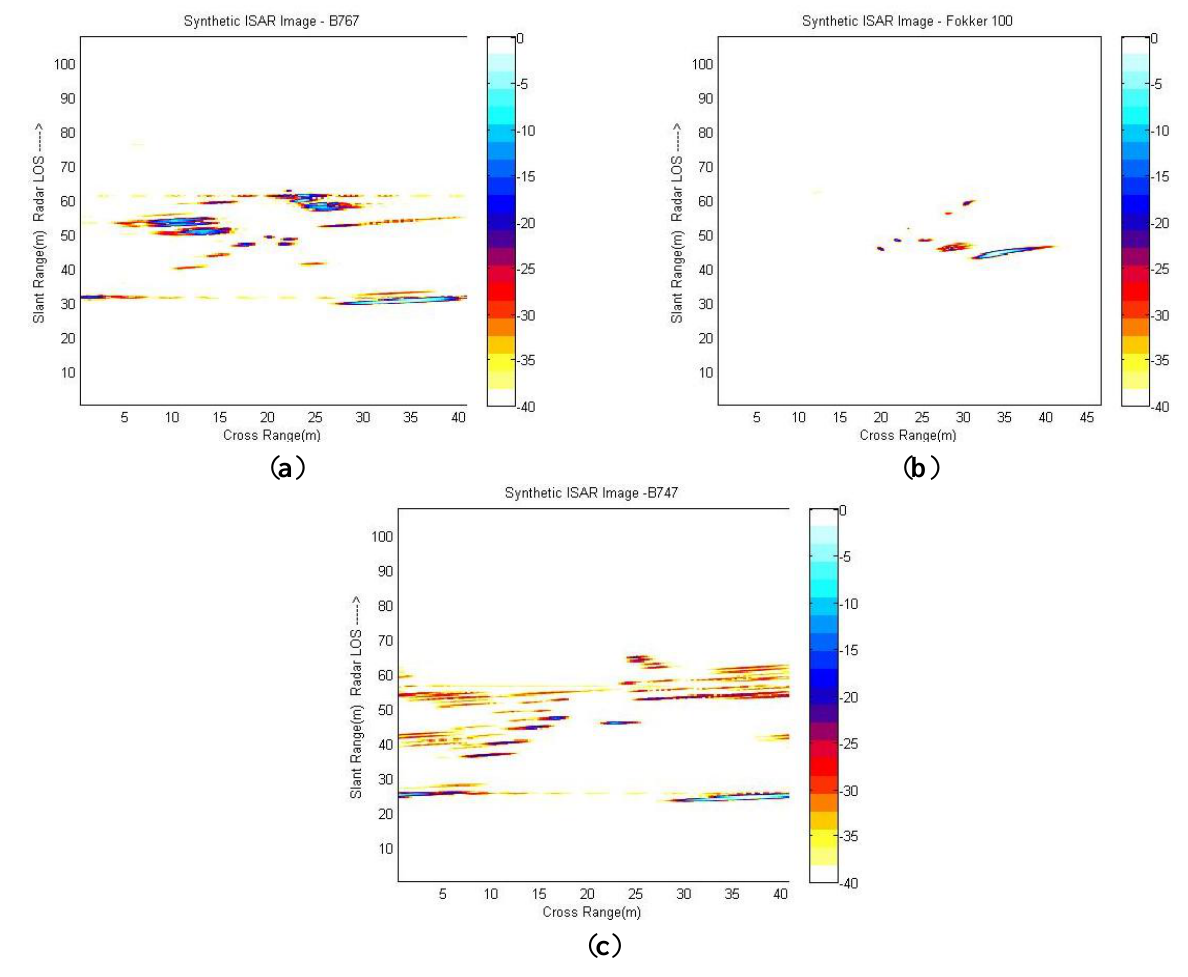
Figure 11. Examples of ISAR images populating the synthetic database; ( a ) Synthetic ISAR image of a Boeing 767; ( b ) Synthetic ISAR image of a Fokker 100; ( c ) Synthetic ISAR image of a Boeing